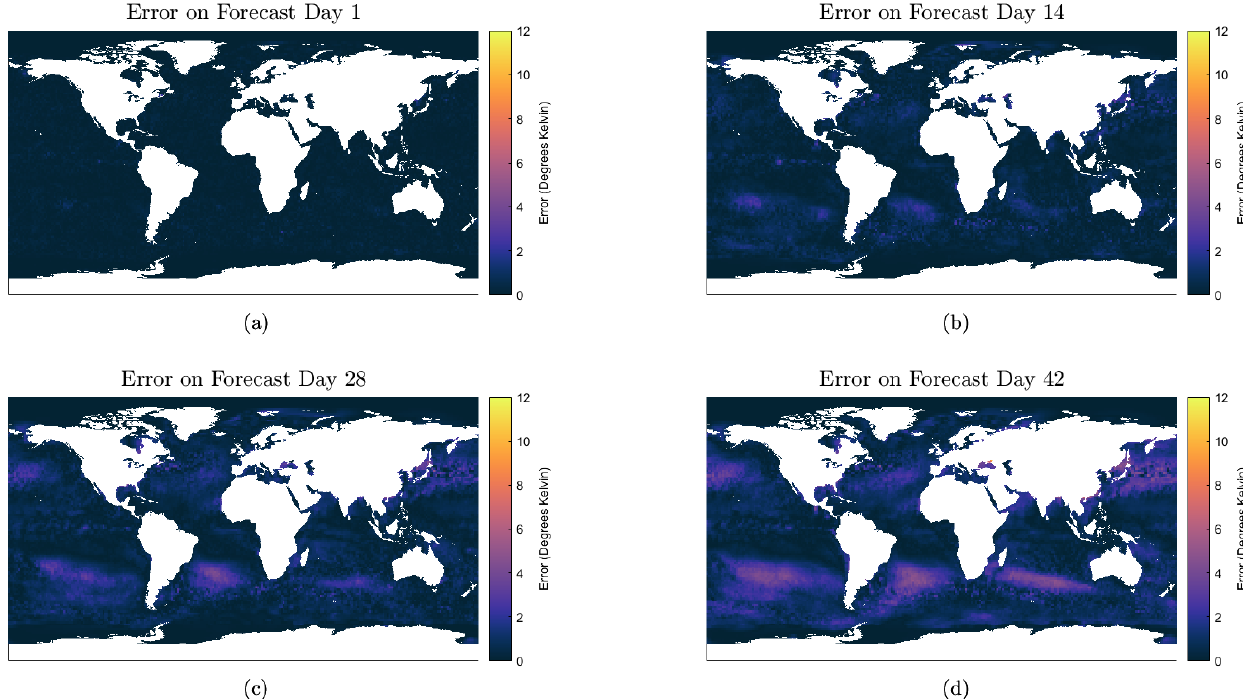
Figure 8. The evolution of the error across the globe for the 6-week forecast. The error at each location is simply the difference between the average forecasted value and the actual value.